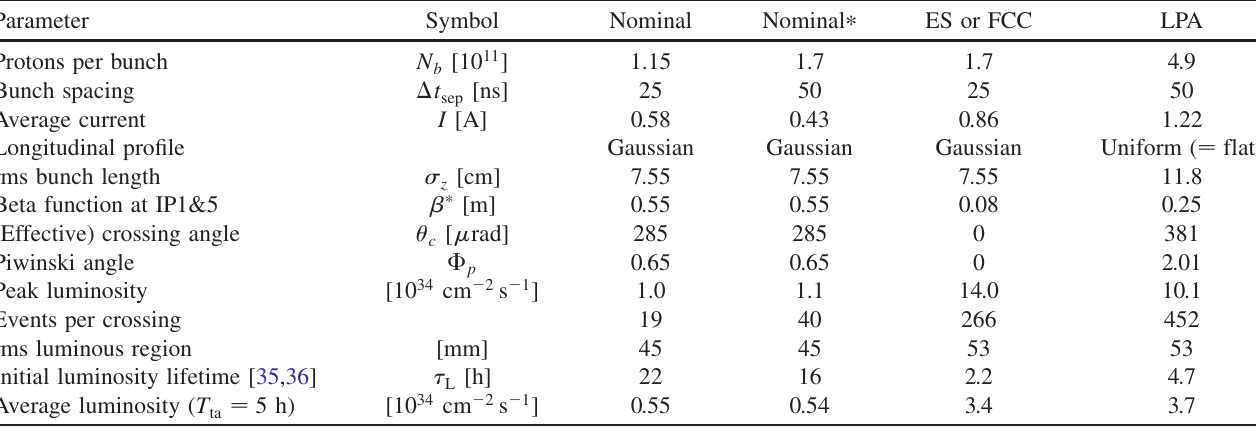
SIMULATIONS OF ELECTRON-CLOUD HEAT LOAD FOR . . TABLE II. Parameters for the (1) nominal LHC and (2) an alternative nominal [asterisk] with half the number of bunches and ultimate bunch intensity compared with those for two upgrade scenarios with (3) more strongly focused ultimate bunches at 25-ns spacing with either early separation and crab cavities [ES] or full crab crossing [FCC], and (4) longer intense flat bunches at 50-ns spacing in a regime of large Piwinski angle [LPA]. The numbers refer to the performance without luminosity leveling. T ta denotes the turnaround time between successive physics runs. The normalized transverse rms emittance is (cid:5)" ¼ 3 : 75 (cid:9) m in all cases.